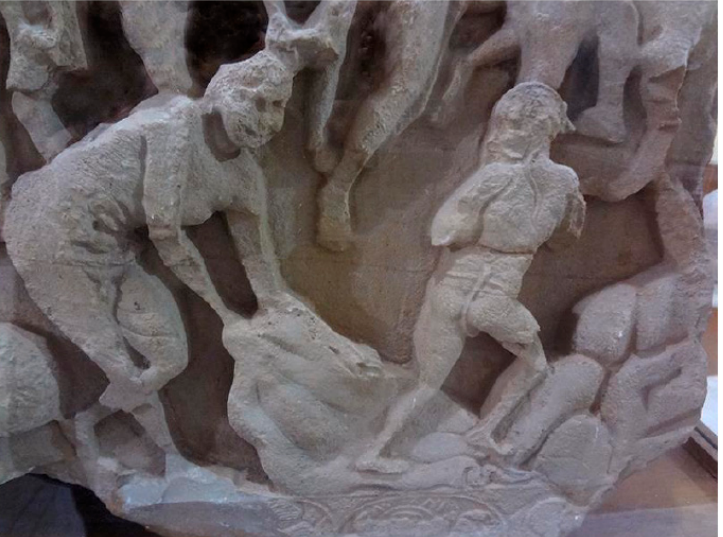
Figure 8. Part of relief no. 124 in Chennai Government Museum © photograph Wojtek Oczkowski.